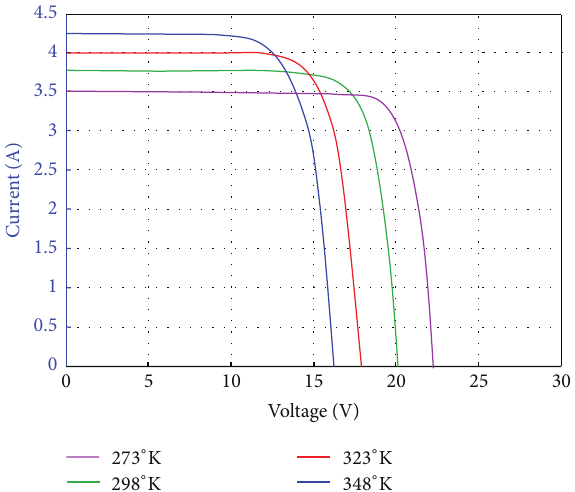
Figure 1: Typical PV solar curve and the effect of temperature.